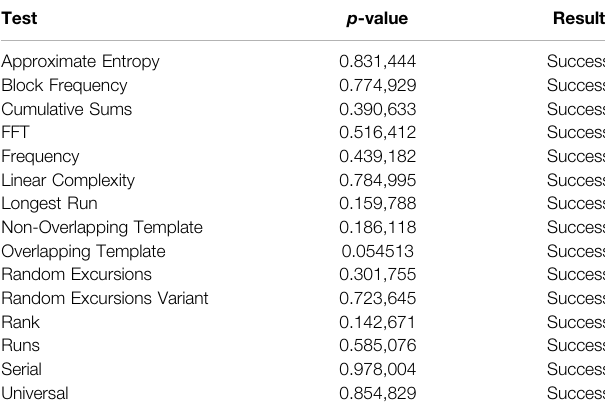
TABLE 5 | Results of SP 800 – 22 test using x 5 after decorrelation operation.